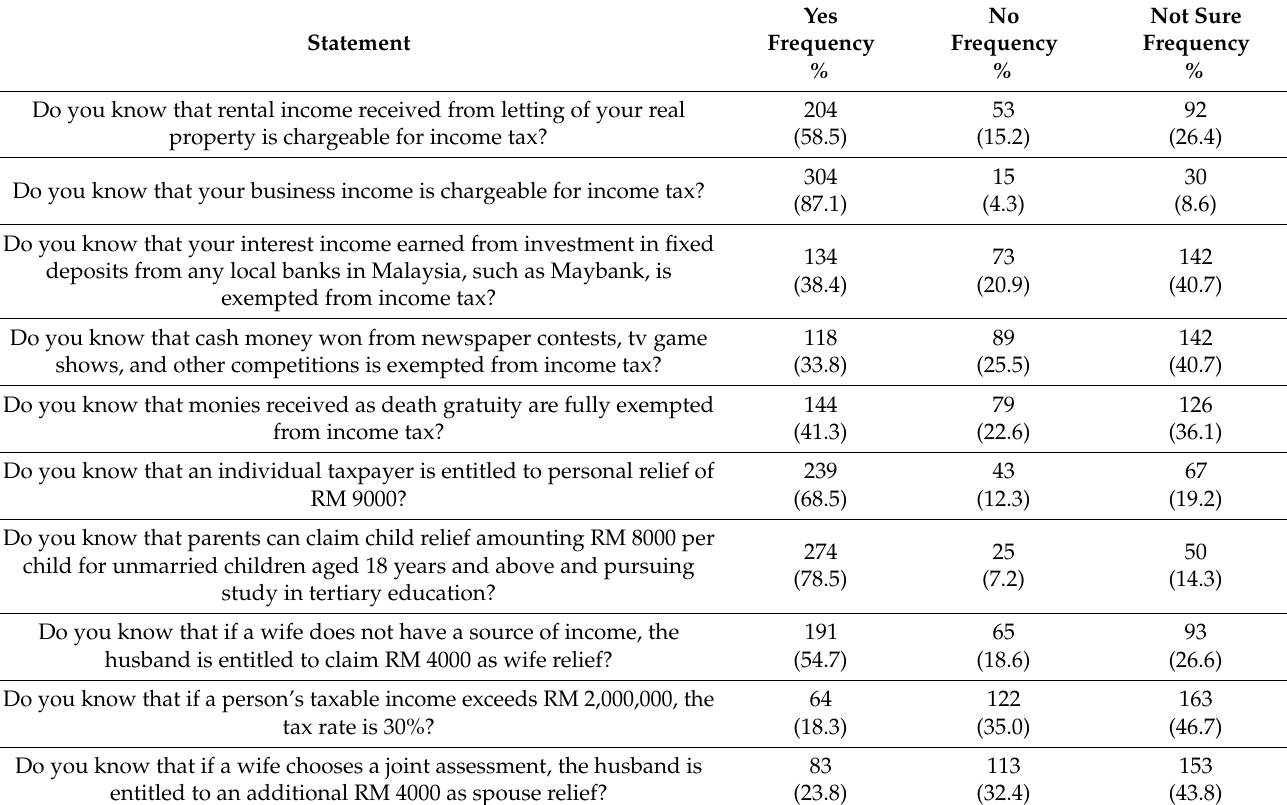
Table 4. Tax knowledge on personal